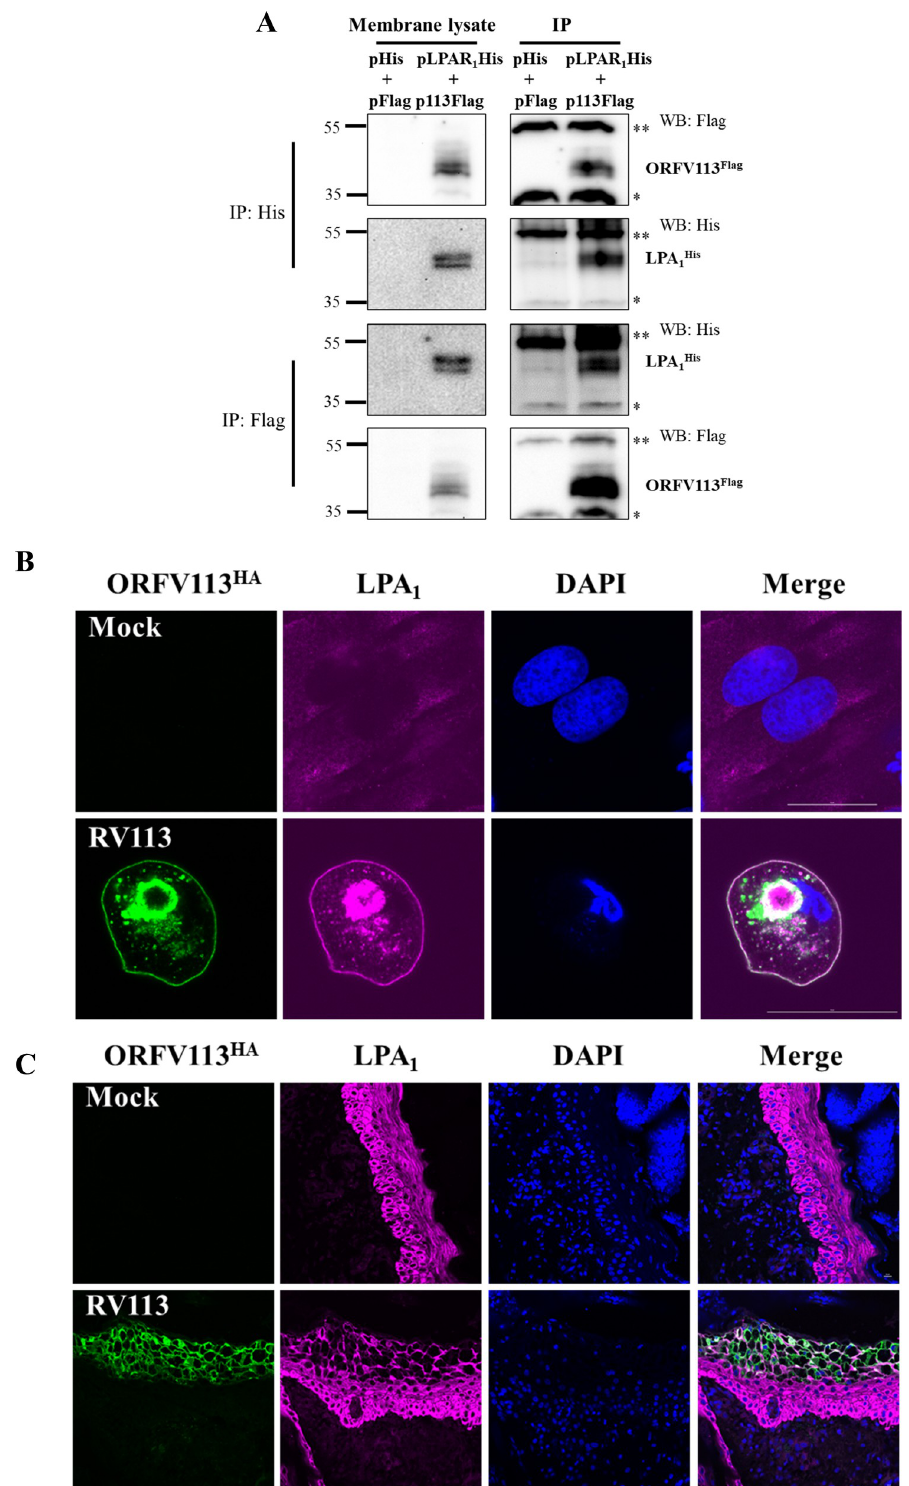
Fig 3. ORFV113 interacts with LPA 1 . (A) Co-immunoprecipitation of ORFV113 with LPA 1 . OFTu cells co- transfected with plasmids pcDNA3.1 His and pCMV Flag (Empty plasmids) or pcDNA3.1-LPA 1His (pLPA 1His ) and pCMV-ORFV113 Flag (p113 Flag ) were harvested at 24 h post transfection and membrane fractions were